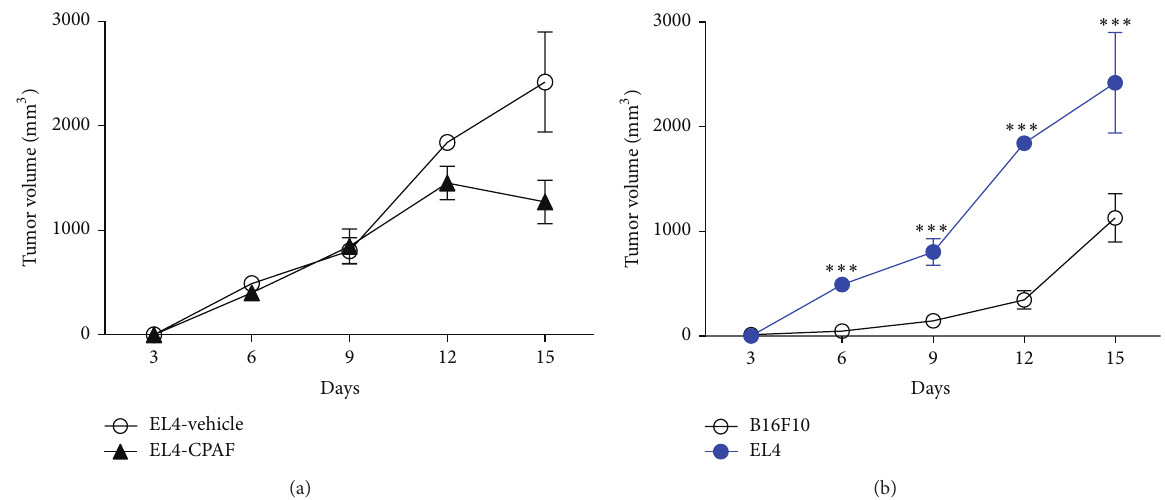
Figure 2: Effect of CPAF on EL4 tumor growth and comparison of basal B16F10 and EL4 tumor growth. (a) Murine syngeneic EL4 lymphoma tumor cells (0.5 × 10 6 ) were implanted subcutaneously into the shaved dorsal hind flanks of C57BL/6 WT mice (4-5 mice/group). CPAF treatment (250 ng/mouse) was given intraperitoneally at days 0, 6, and 12. Tumor growth was measured and tumor volumes (major circumference × minor circumference 2 /2) were compared between the groups. (b) The basal growth rates between B16F10 and EL4 tumors were compared by assessing tumor volumes (major circumference × minor circumference 2 /2). Statistical differences were noted between EL4 and B16F10 tumors at day 6 ( ∗∗∗ 𝑃 < 0.001 ), day 9 ( ∗∗∗ 𝑃 < 0.001 ), day 12 ( ∗∗∗ 𝑃 < 0.001 ), and day 15 ( ∗∗ 𝑃 < 0.01